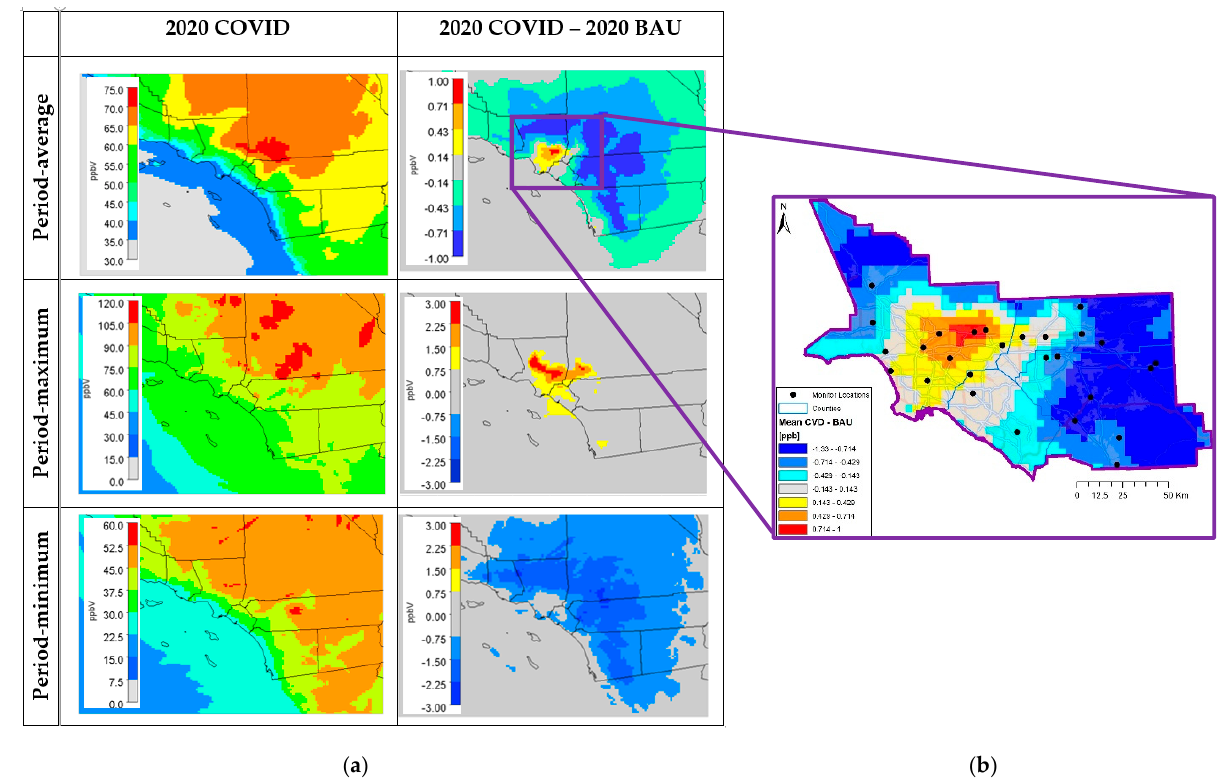
Figure 10. 1 June–31 July impacts of the COVID-19 emissions reductions on ozone, estimated by CMAQ: ( a ) Period-average, period-maximum, and period-minimum MDA8 ozone spatial maps for